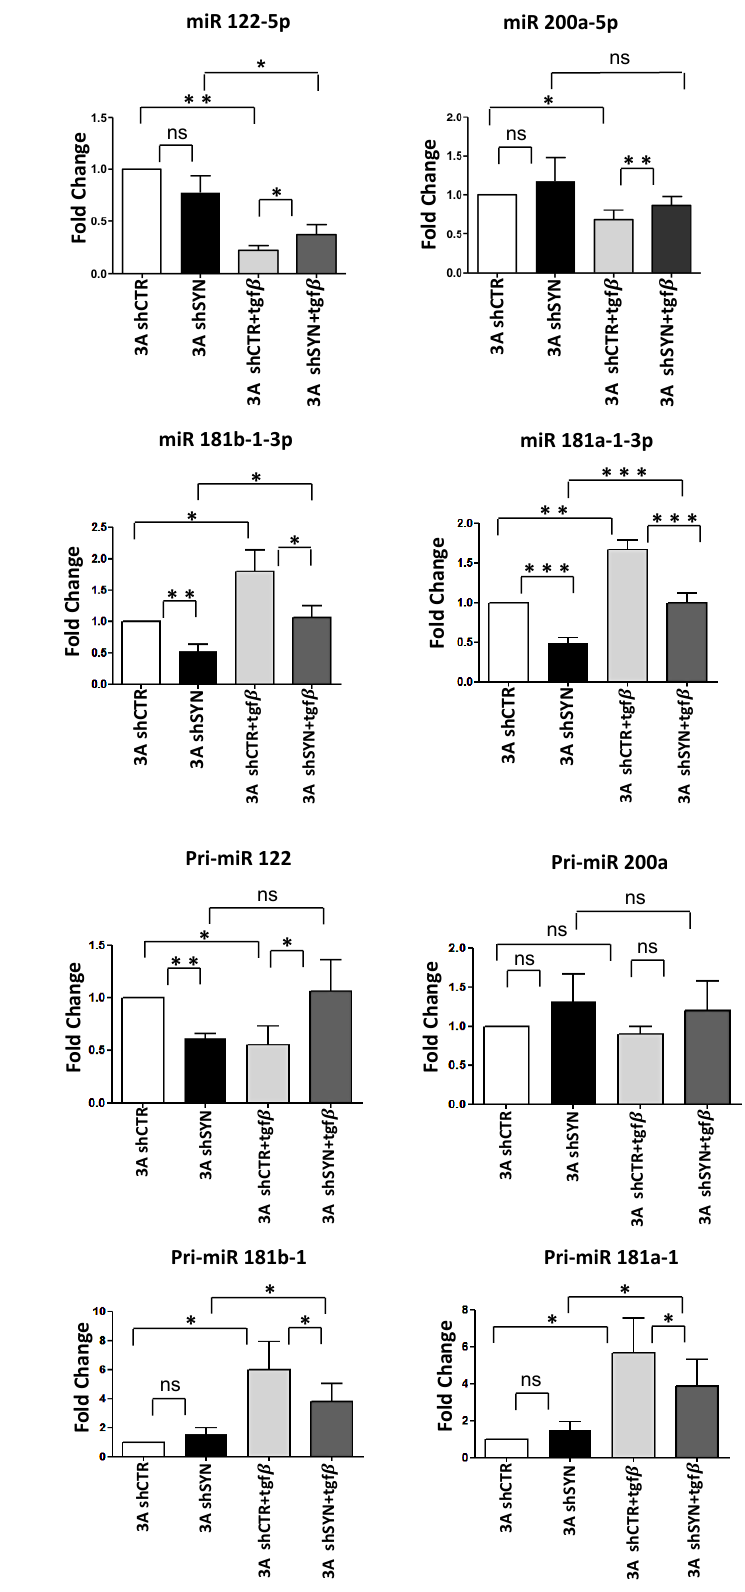
Figure 3. SYNCRIP controls anti and pro-EMT miRNA levels in hepatocytes undergoing TGF β - induced EMT. ( A ) qRT-PCR analysis of intracellular levels of anti-EMT microRNAs ( miR-122-5p